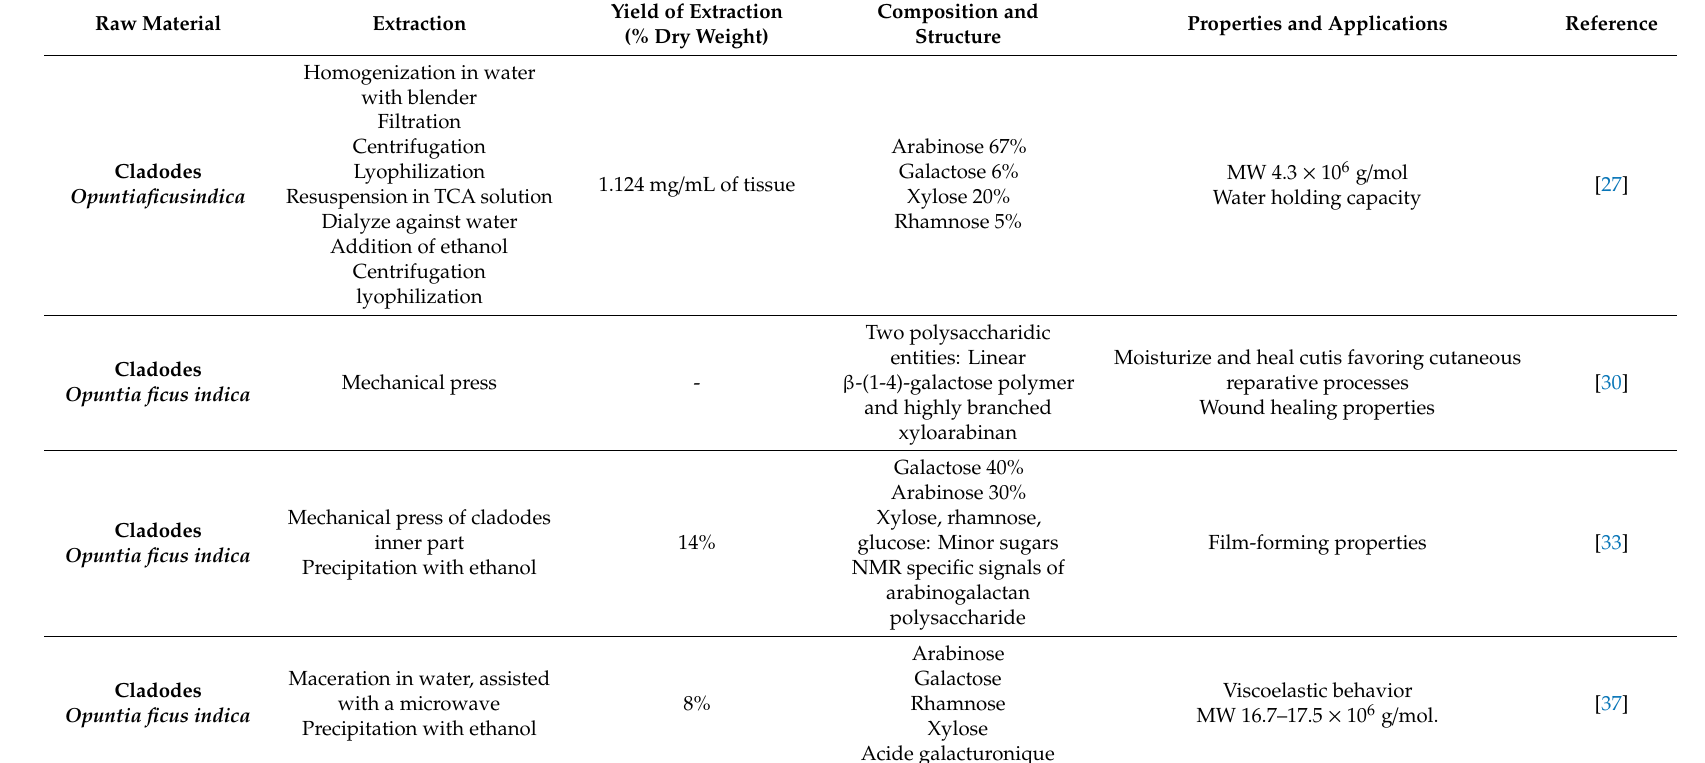
Table 1. Method and properties of mucilage from di ff erent cactus species and plant